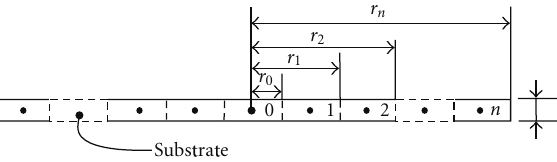
Figure 6: Thermal conduction partition model in the